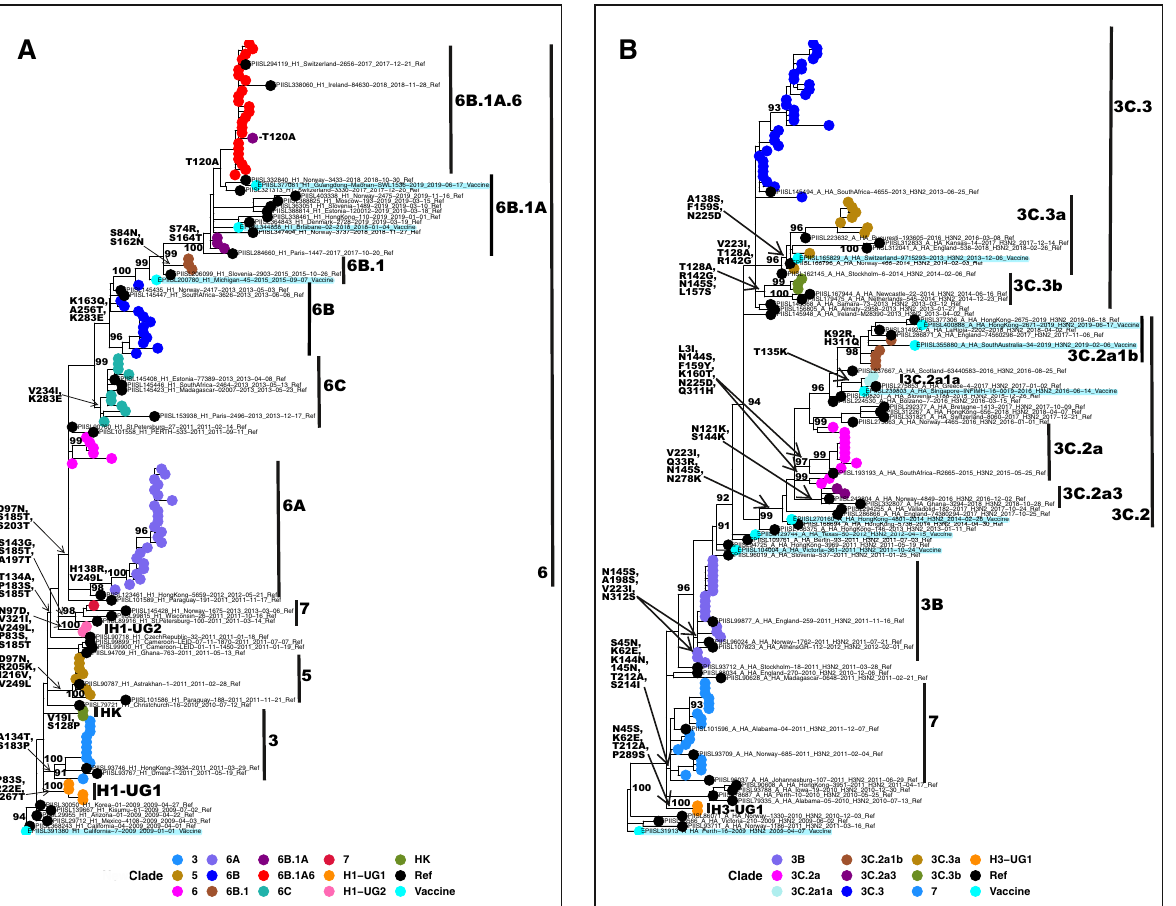
Figure 3. Genetic clades of influenza A viruses that previously circulated in Uganda during the 2010– 2018 seasons. All labelled clades (indicated by black bars) were inferred based on the signature amino acid substitutions in the HA1 protein indicated on the tree trunk in bold. ( A ) Shows clades for 2010–2018 A(H1N1) pdm09 viruses. Novel clades H1-UG1 and H1-UG2 are indicated. Genetic clade 6 diverged into 6A, 6B, and 6C. All clade 3, 5, and 7 viruses were collected from Entebbe and Kampala (Central Uganda) and circulated in 2010– 2011. ( B ) Shows clades for 2010–2017 A(H3N2) viruses. A novel clade H3-UG1 is indicated. Clade 3 persisted in all 9 years. A similar figure with the full sequence names is provided in Supplementary Fig.